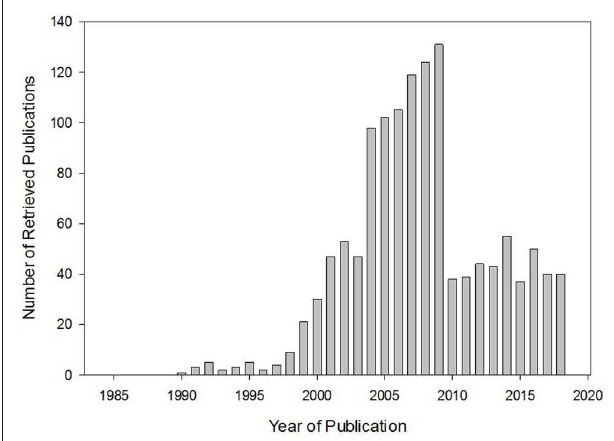
FIGURE 1 | Relevant publications retrieved from PubMed search using “herb-drug interaction” as a search term. The trend shows the introduction of and enhanced interest in herb-drug interaction. Interest has been maintained in this area over the